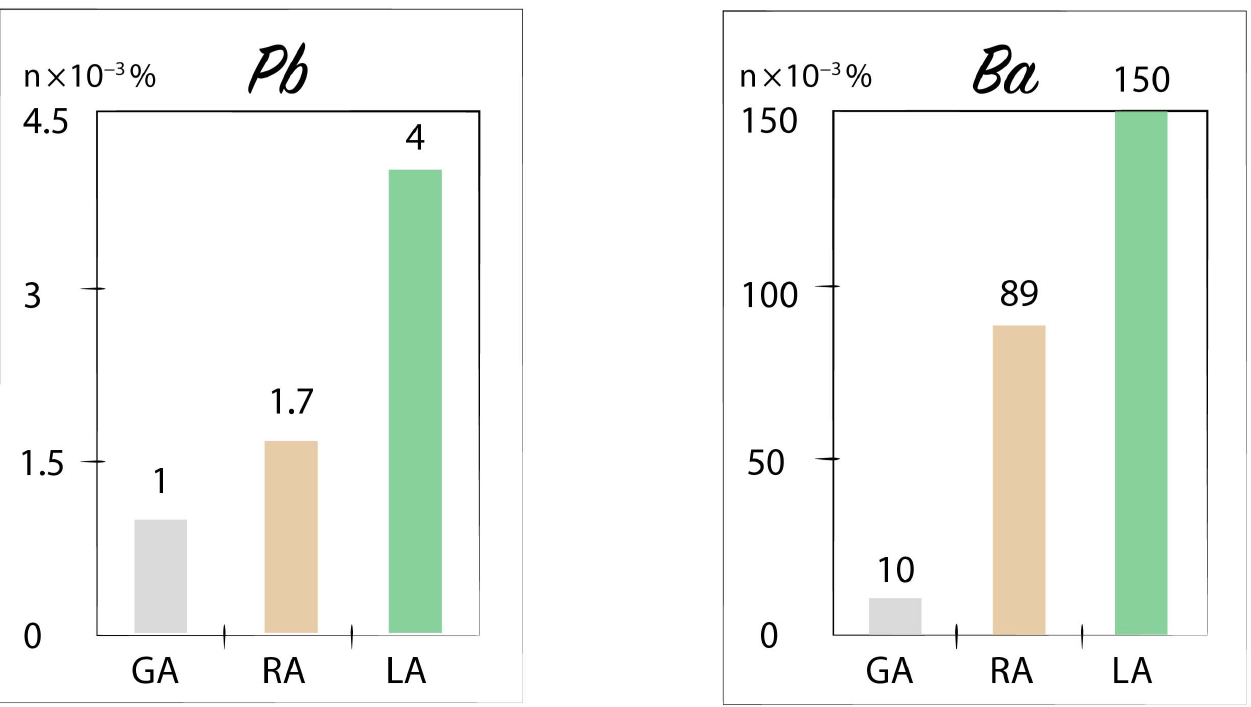
Figure 2. Metal accumulation in different milieu: GA—global abundance in the plants of Earth (after Kabata-Pendias; Tkalich [41,42]); RA—regional abundance of the North Caucasus geochemical province; LA—local average content in the ash of hornbeam ( Carpinus ) growing over mercury, oil, and gas fields.